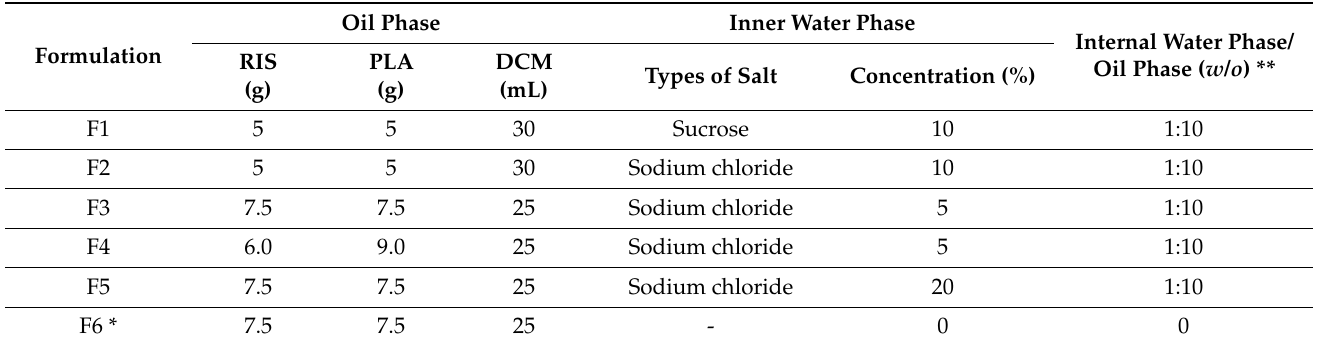
Table 1. Formulation of